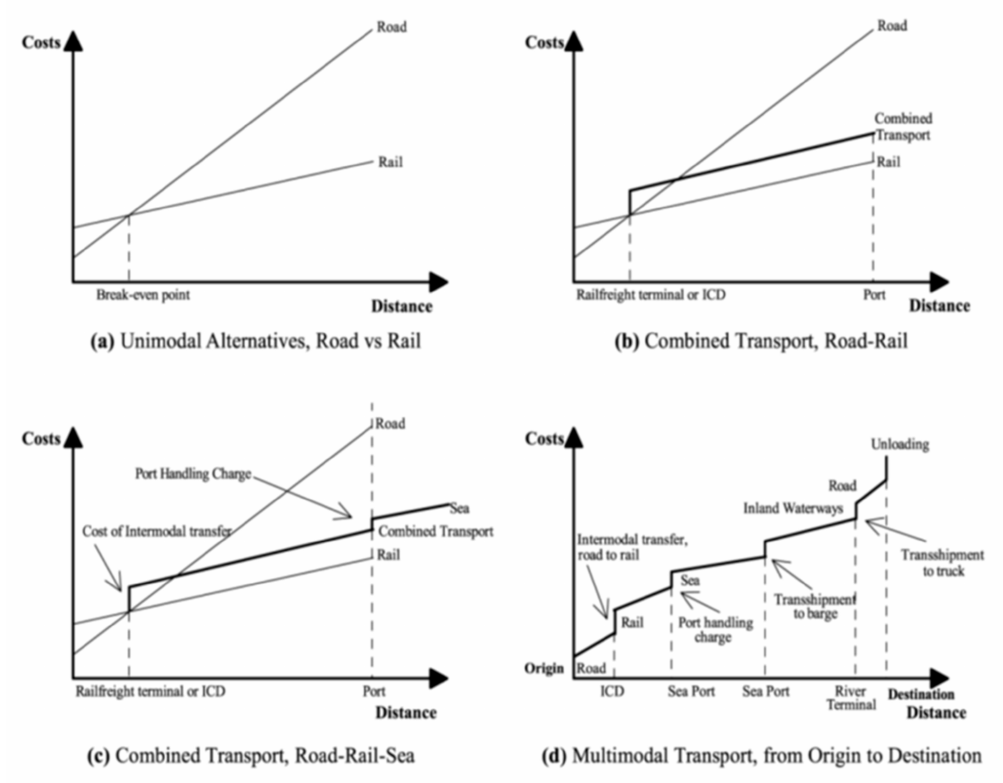
Figure 2. Multimodal transport cost model ( Source: Adapted from Beresford